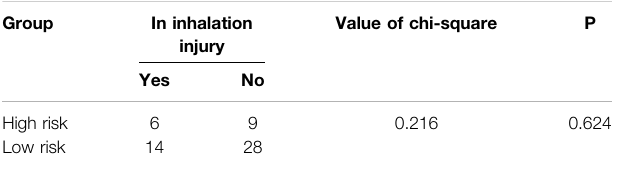
TABLE 3 | Differences between high- and low-risk burns that were divided by the regression model in inhalation injury.